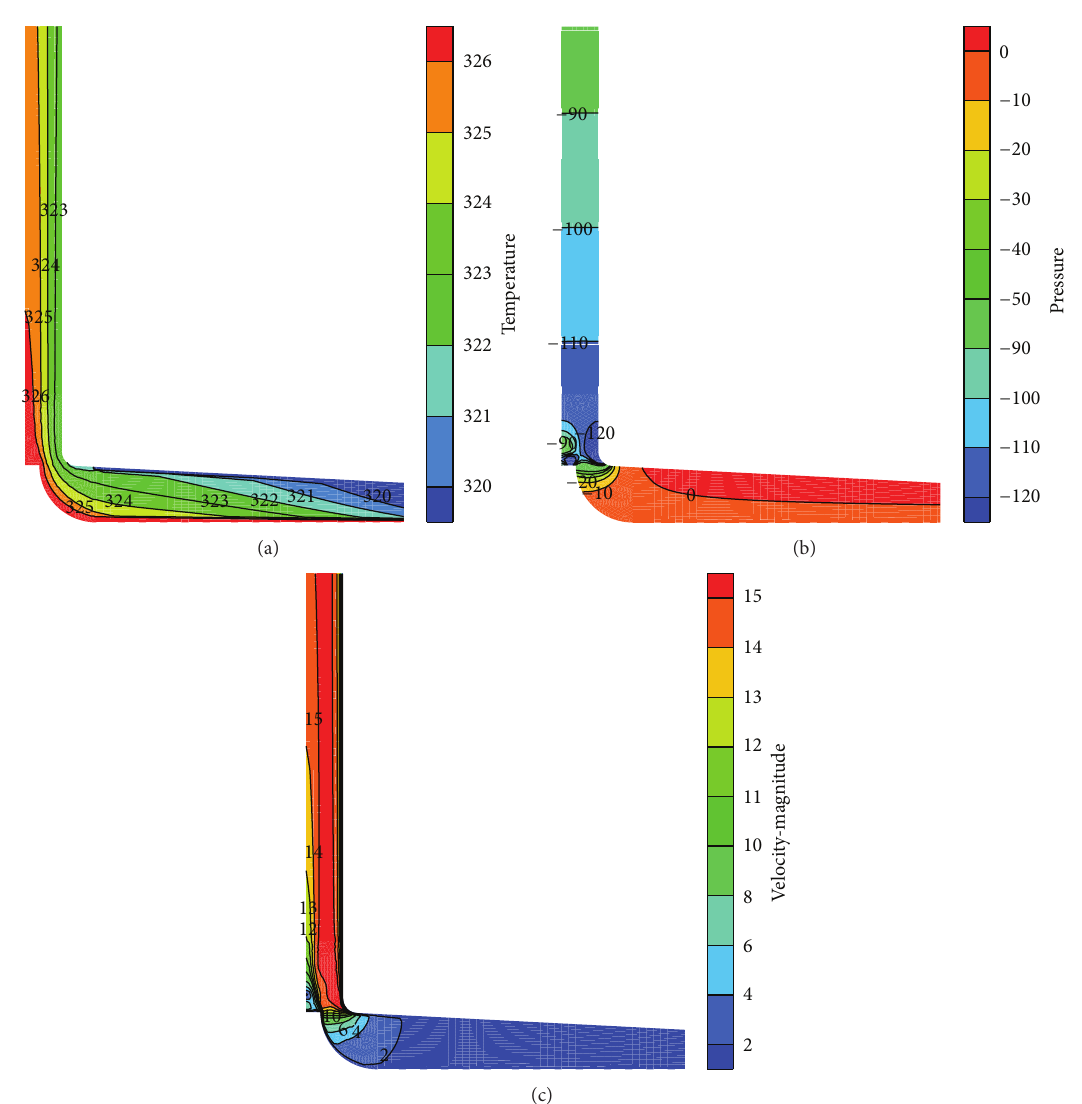
Figure 4: Temperature, velocity, and pressure fields of the CSCPP when 𝐼 unit: m/s).